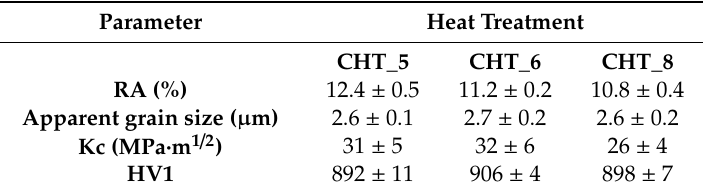
Table 1. Mean values of retained austenite (RA), apparent grain size, plane strain fracture toughness (K C ) and Vickers hardness (HV1) of taps after the different heat treatments.